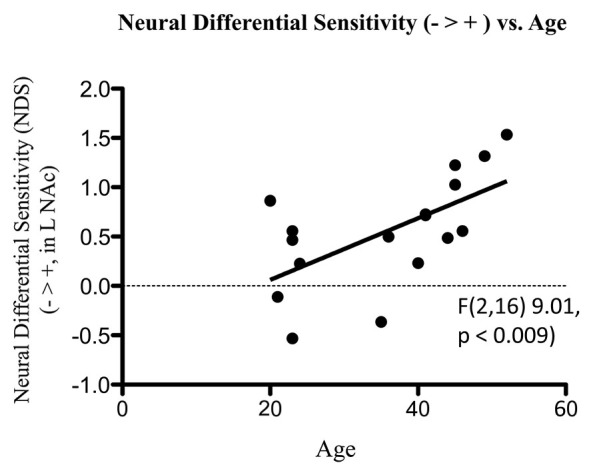
Association of NDS from BOLD signal collected by fMRI with age. The line of best fit is shown from this association.